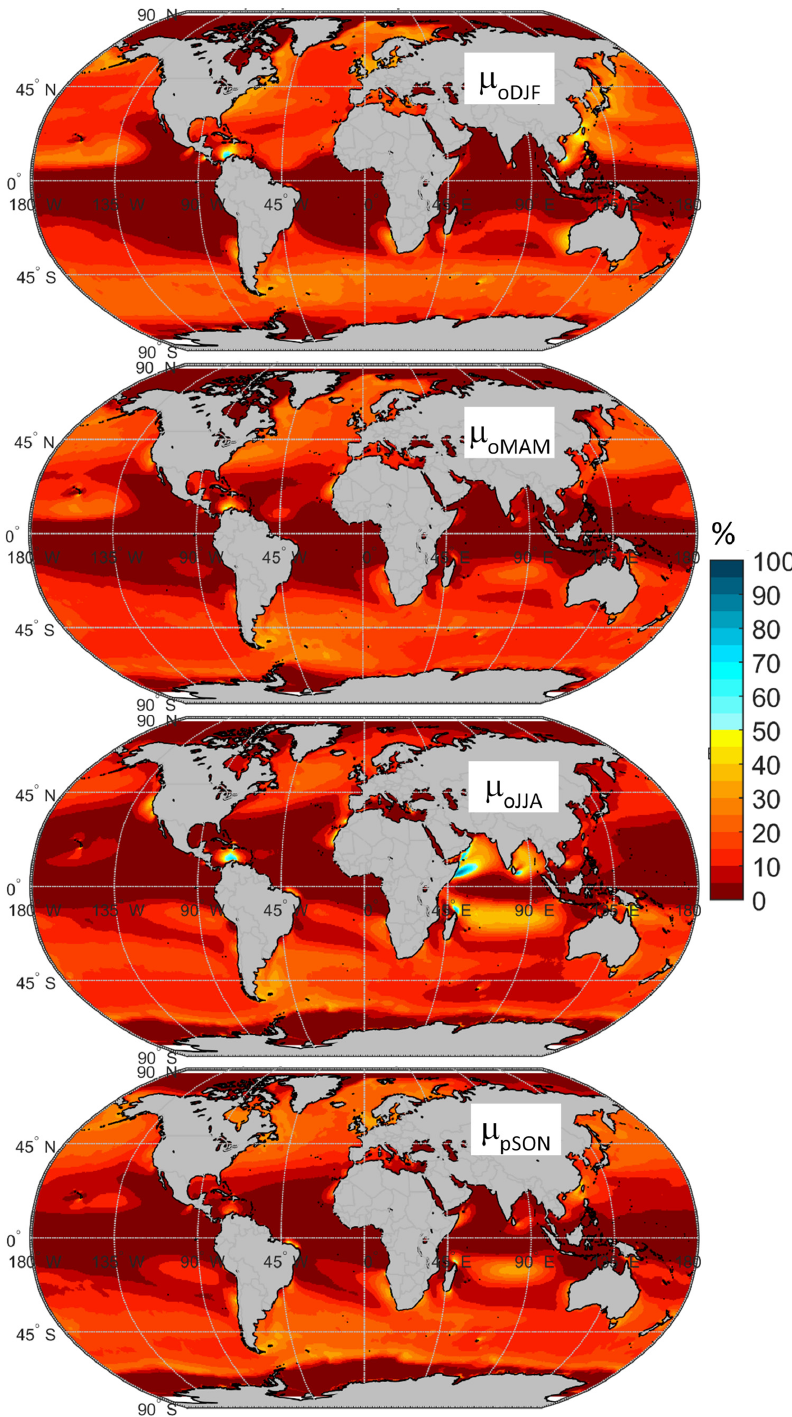
Figure 15. Global distribution of the mean seasonal optimal operability. During the winter season (DJF) in the North Atlantic maximum values of µp(DJF) of 30-35% are reached near the US east coast and in the Baltic Sea, reaching 35–40% in the